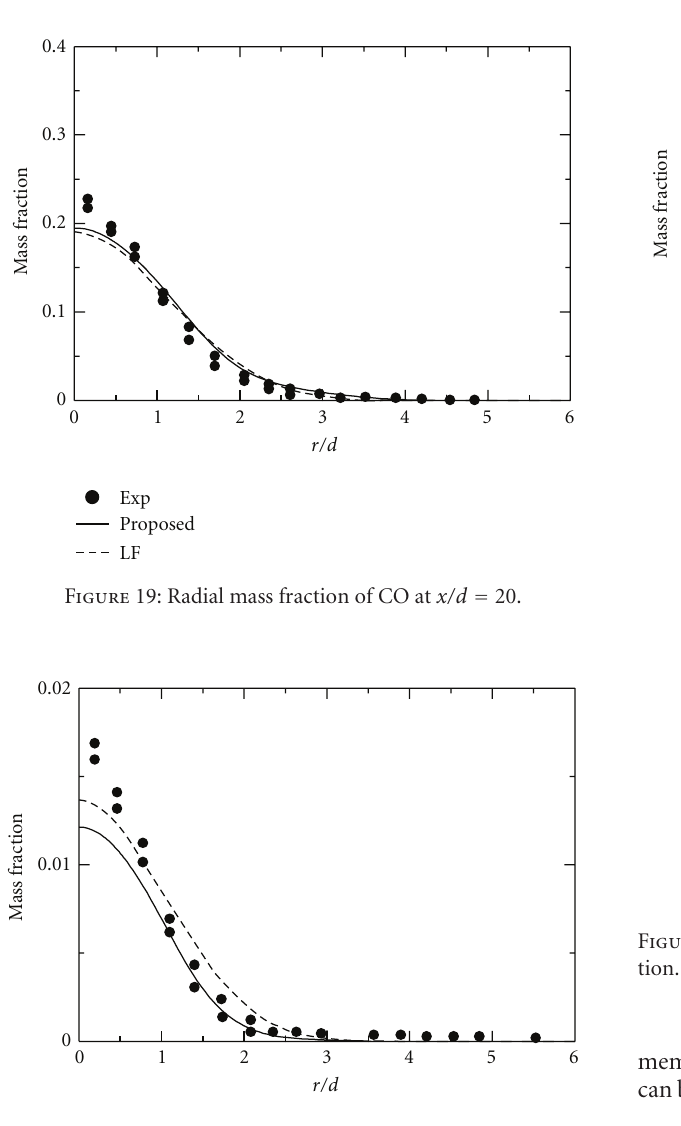
(15 Mbyte), 100 × 100 × 1 (1.2 Mbyte), and 200 × 200 ×